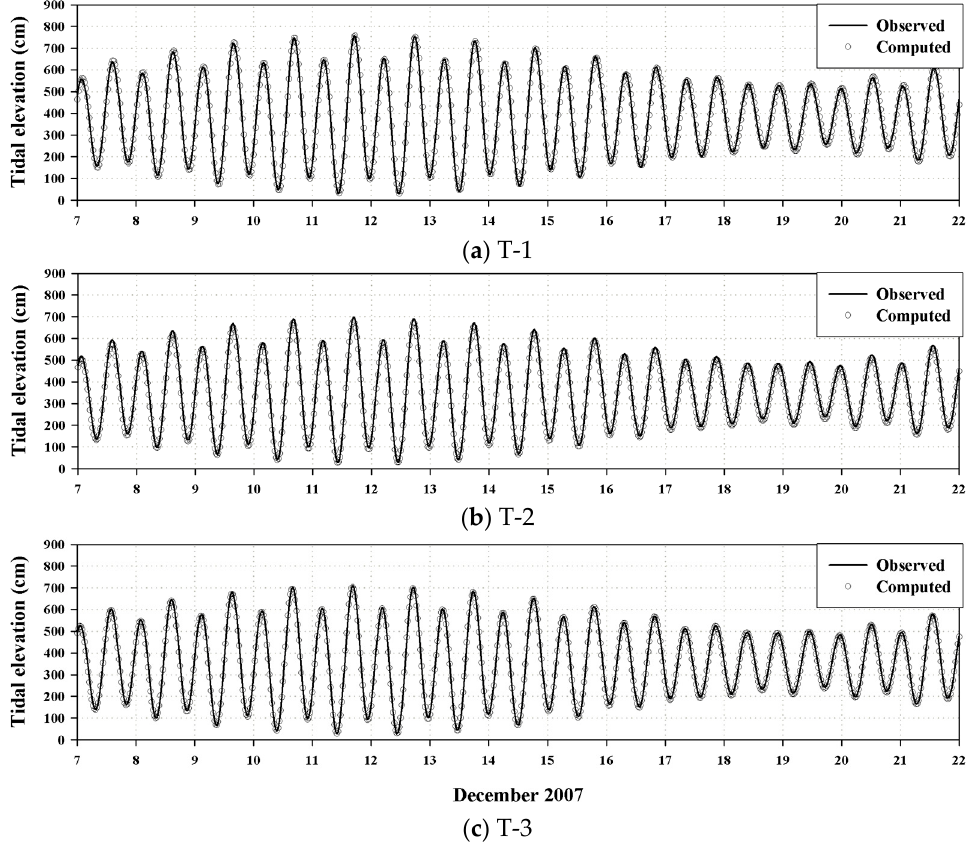
Figure 8. Comparison between observed and computed tidal elevation time series at ( a ) T-1, ( b ) T-2, and ( c ) T-3. The reference time is Korea standard time (KST).